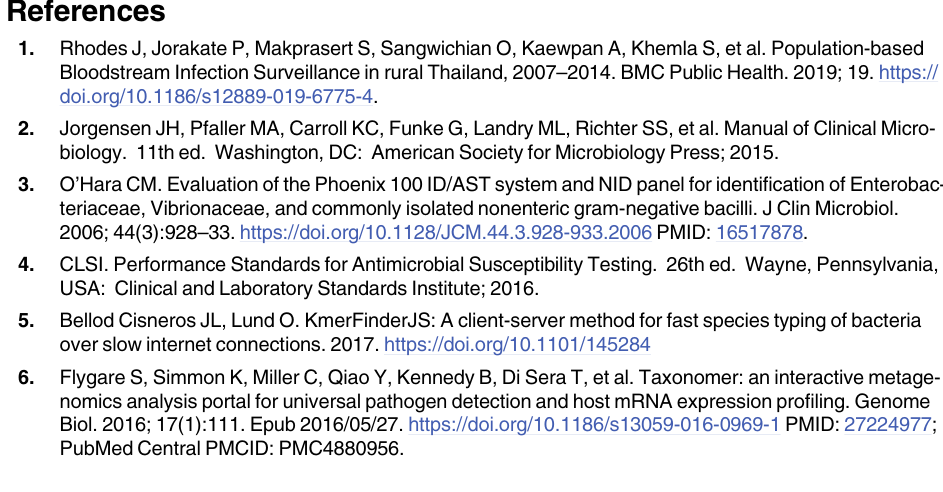
S2 Tables. WGS analysis summaries. Collated data from results generated by the 3 web-based platforms: KmerFinder, Taxonomer and One Codex for the whole genome sequence data from 12 unidentified